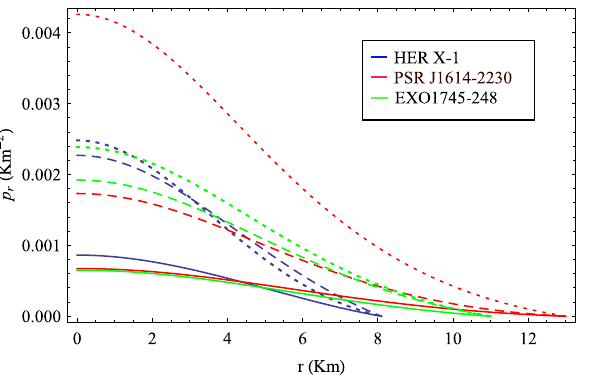
Fig. 3 Radial variation of radial pressure ( ˜ p r ) for different compact objects as indicated in the figure. Here plots with solid, dashed and dotted lines correspond to D = 4 , 5 and 6 respectively. To obtain the plots we choose (i) α = 0 . 4, γ = 0 . 45 when D = 4; α = 0 . 3, γ = 0 . 25 when D = 5 and α = 0 . 25, γ = 0 . 2 when D = 6 for HER X-1, (ii) α = 0 . 4, γ = 0 . 5 when D = 4; α = 0 . 3, γ = 0 . 25 when D = 5 and α = 0 . 2, γ = 0 . 15 when D = 6 for PSR J1614-2230, (iii) α = 0 . 4, γ = 0 . 5 when D = 4; α = 0 . 3, γ = 0 . 2 when D = 5 and α = 0 . 2, γ = 0 . 25 when D = 6 for EXO1745-248